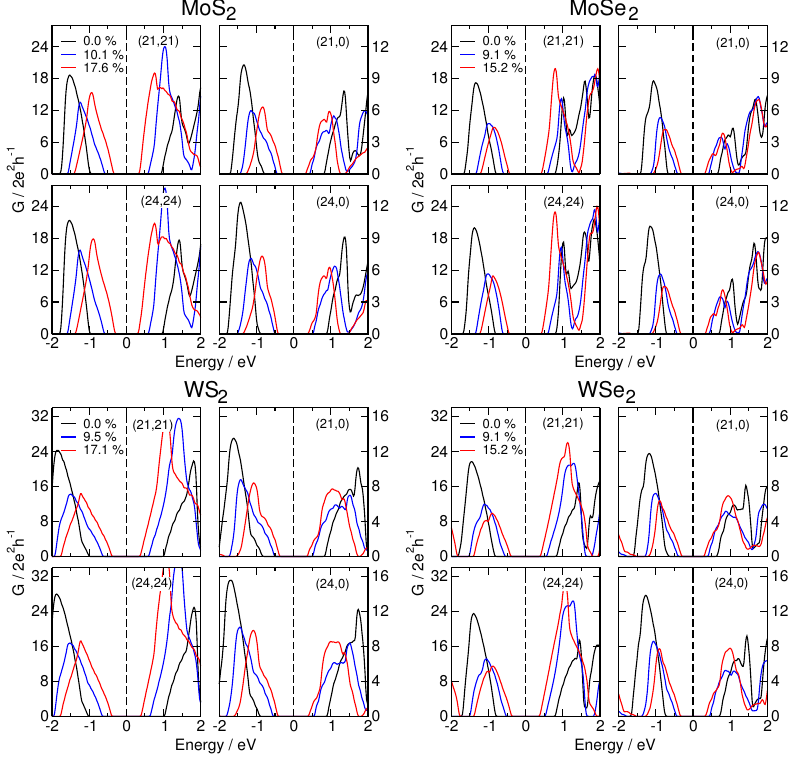
Figure 7. The electron quantum conductance of TX the tube